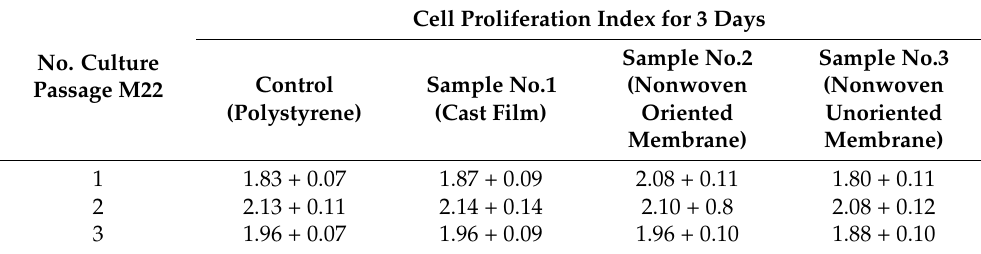
Table 4. Proliferative activity of fibroblasts of the M22 line in the control (polystyrene) and cultivated on cell carriers studied experimental samples from P(3HB-co-4HB). Cell Proliferation Index for 3 Days Sample No.2 Sample No.3 No. Culture Control Sample No.1 (Nonwoven (Nonwoven Passage M22 (Polystyrene) (Cast Film) Oriented Unoriented Membrane)